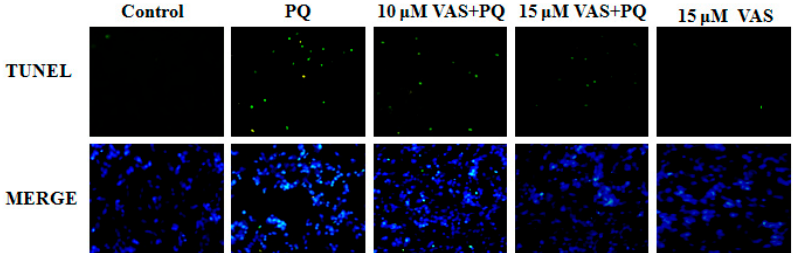
Figure 4. E ff ect of vasicinone on paraquat-induced apoptosis in SH-SY5Y cells. Terminal deoxynucleotide transferase-mediated dUTP nick end-labeling (TUNEL) staining was used to study the protective e ff ect of vasicinone on paraquat-induced apoptosis. The green fluorescent signal was observed in TUNEL stain, and fluorescent blue (4 (cid:48) ,6-diamidino-2-phenylindole, DAPI) signal was observed in DAPI stained nuclei. VAS: Vasicinone; VAS + PQ: Vasicinone +